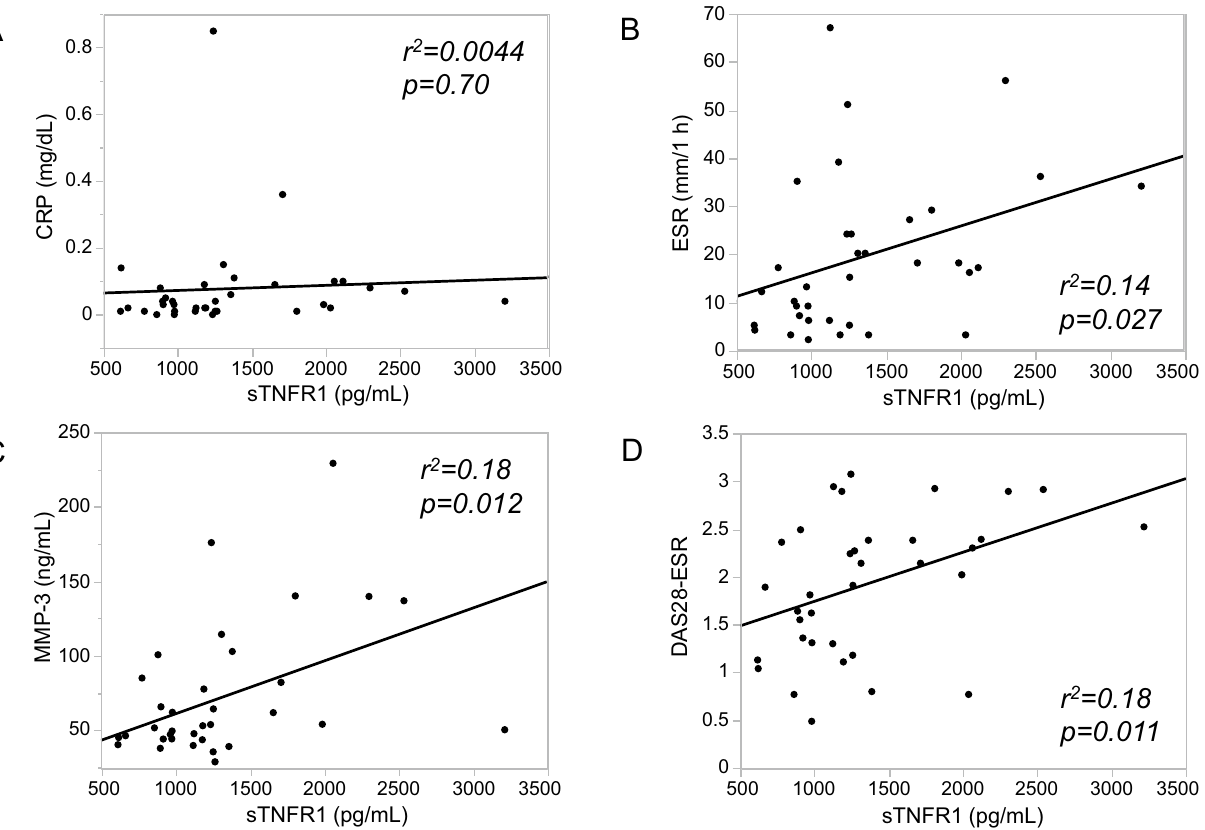
Figure 2. Correlation of plasma sTNFR1 concentration with RA disease activity at baseline (n = 36). The correlation coefficient (r) and p value were determined by Spearman’s rank test. ( A ) CRP; r 2 = 0.0044, p = 0.70. ( B ) ESR; r 2 = 0.14, p = 0.027. ( C ) MMP-3; r 2 = 0.18, p = 0.012. ( D ) DAS28-ESR; r 2 = 0.18, p = 0.011.